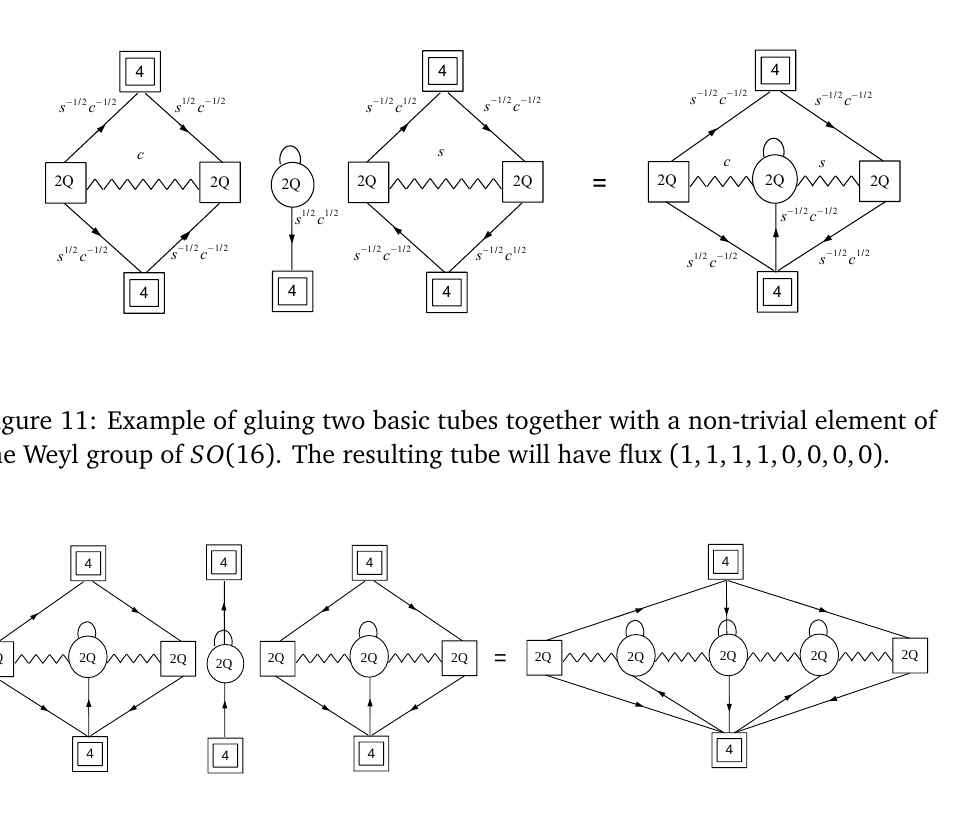
Figure 12: Gluing two ( 1,1,1,1,0,0,0,0 ) tubes together with a trivial element of